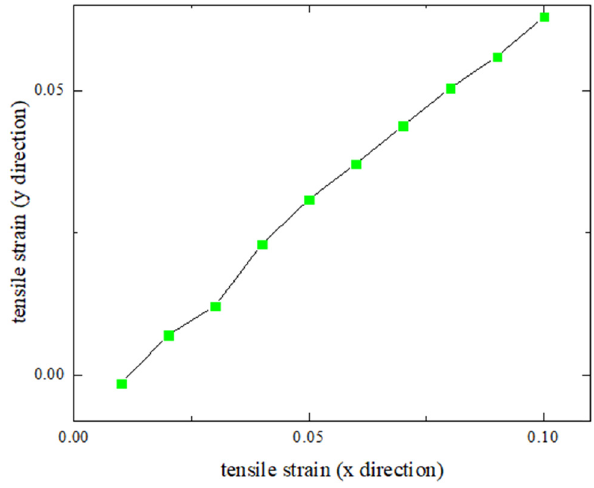
Figure 6: The y - direction strain as a function of x - direction when stretched in the x -